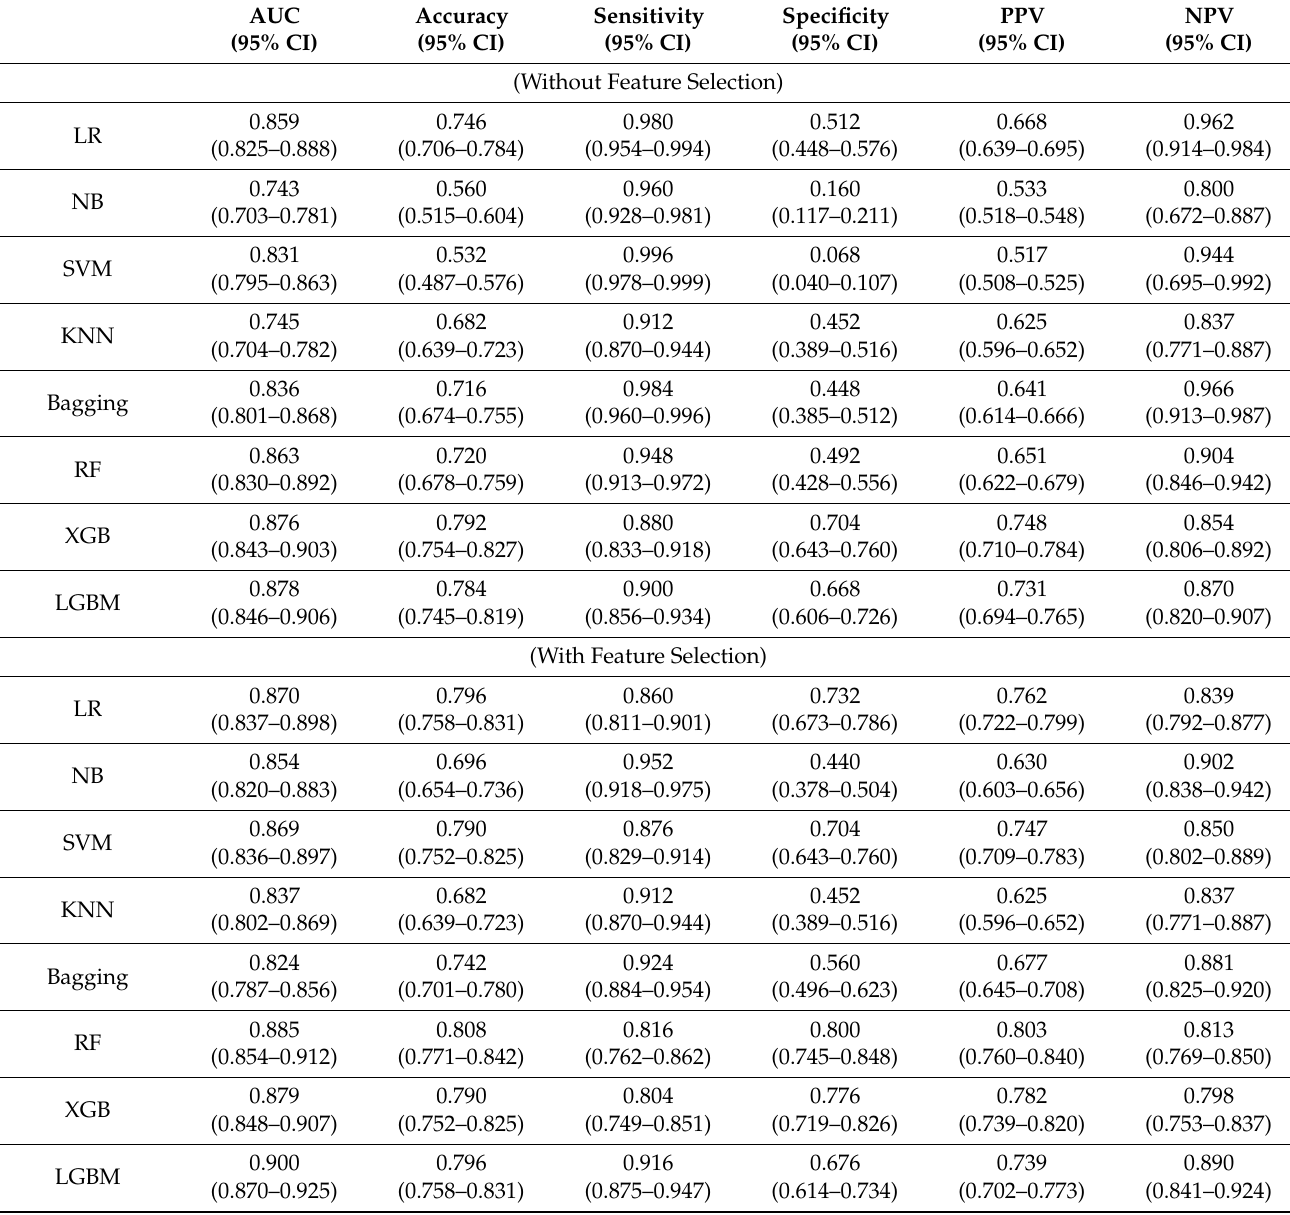
Table 3. Each machine learning model’s AUC, sensitivity, specificity, PPV, and NPV for differentiating between COVID-19 and pneumonia with and without feature